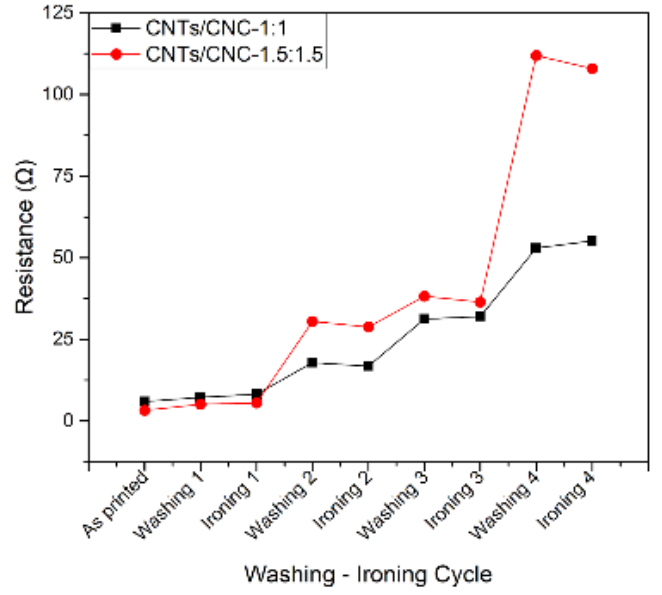
Figure 11. Resistance change after 4 washing and ironing cycles; refers to 5 layers CNTs/CNC—1:1 and CNTs/CNC—1.5:1.5 inks screen printed samples.